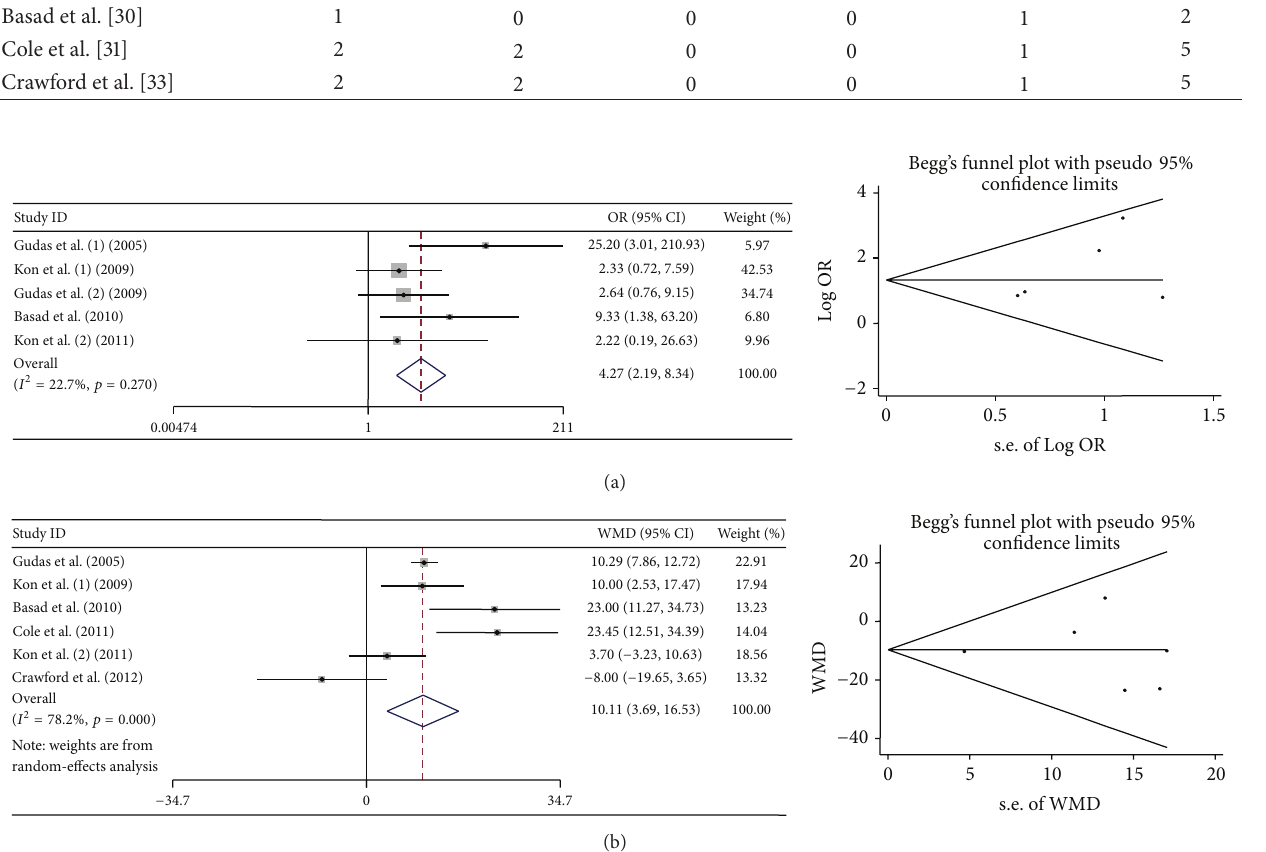
Figure 3: Forest plots and Begg’s funnel plots of studies comparing cell-based with the cell-free cartilage treatments. (a) Forest plots and Begg’s funnel plots conducted by using the number of patients achieved excellent and good results. (b) Forest plots and Begg’s funnel plots conducted by using mean scores and standard